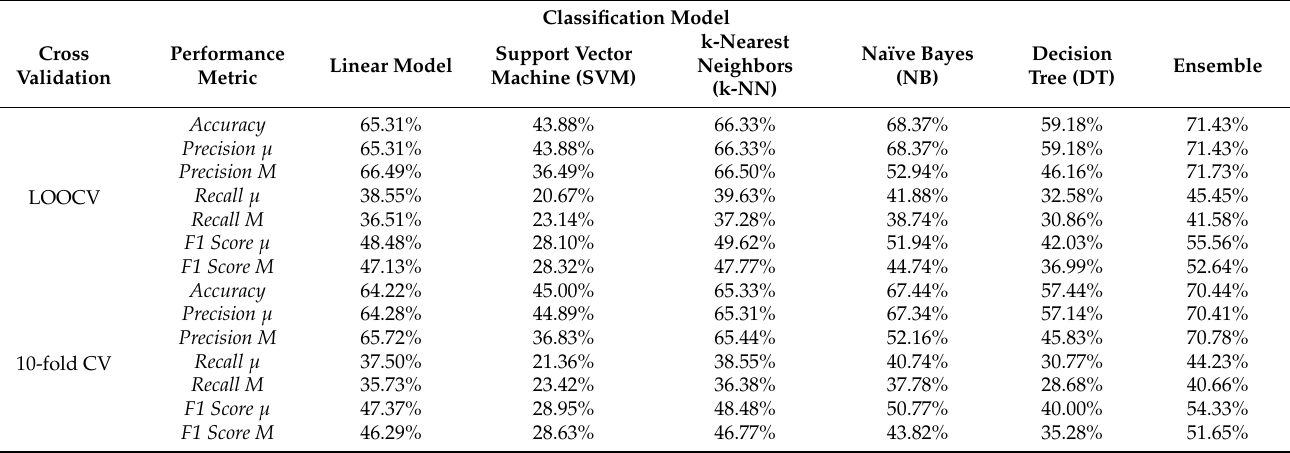
Table 8. Classification Results with MRMR feature selection using, respectively, LOOCV and 10-fold Cross Validation (4